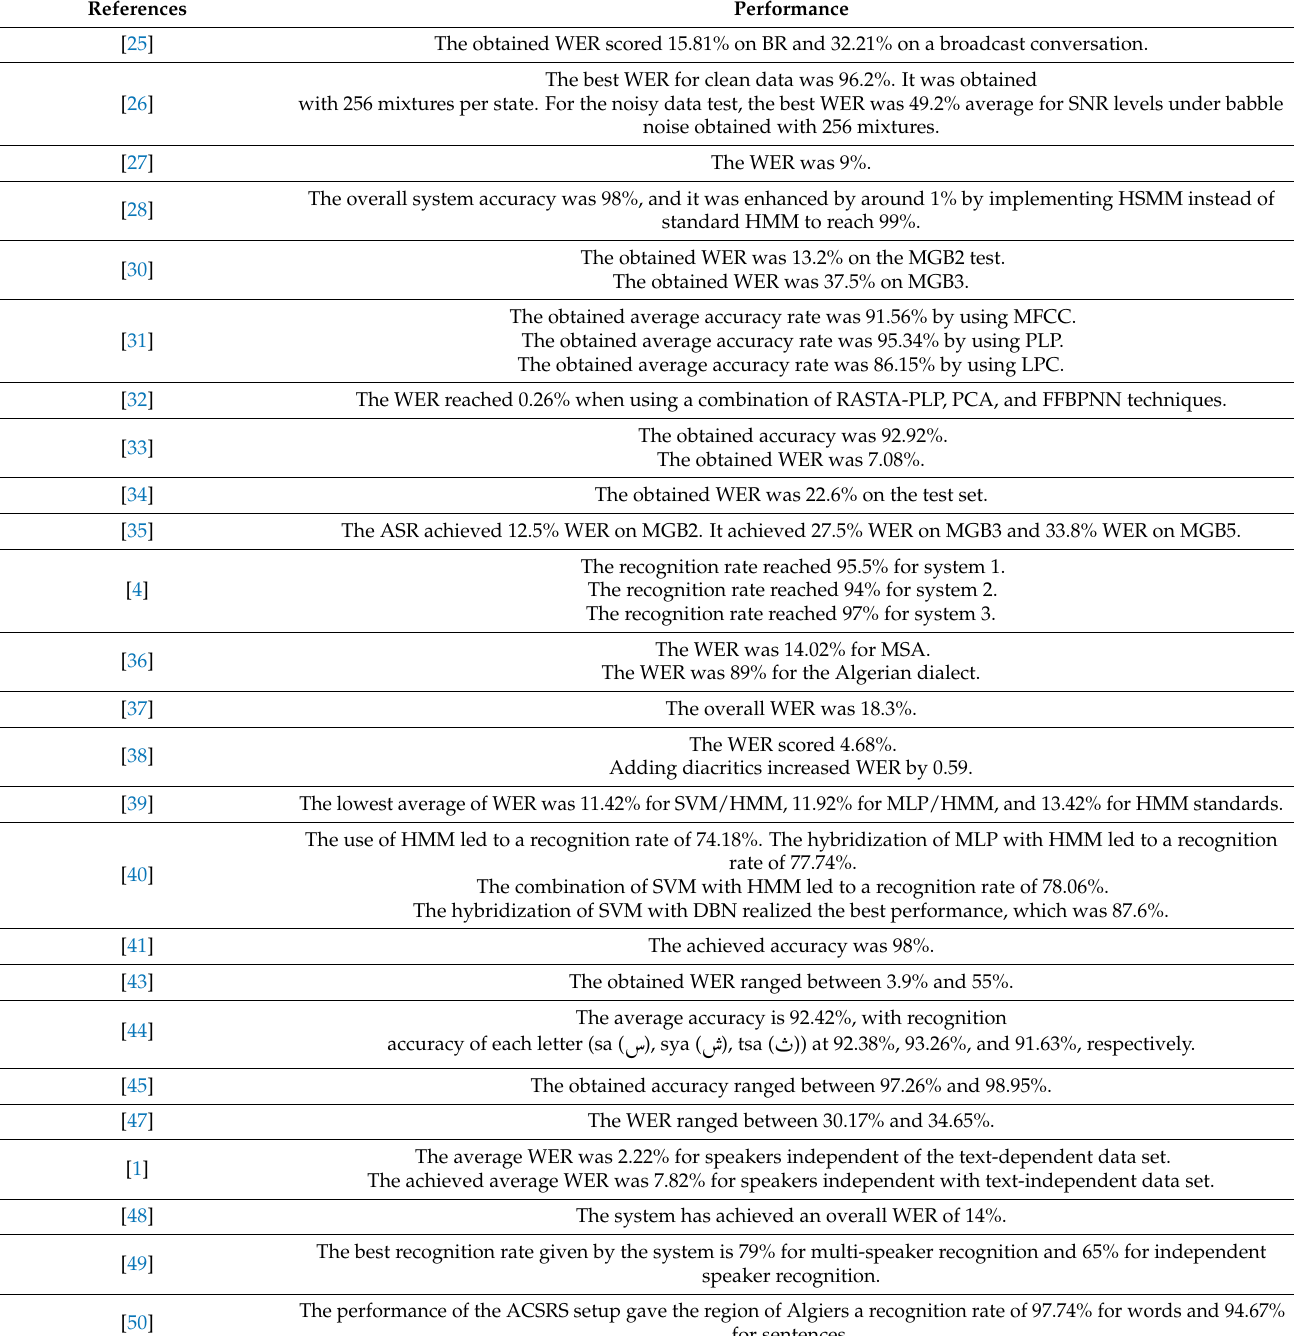
Table 10. Performance of the retained Arabic speech recognition